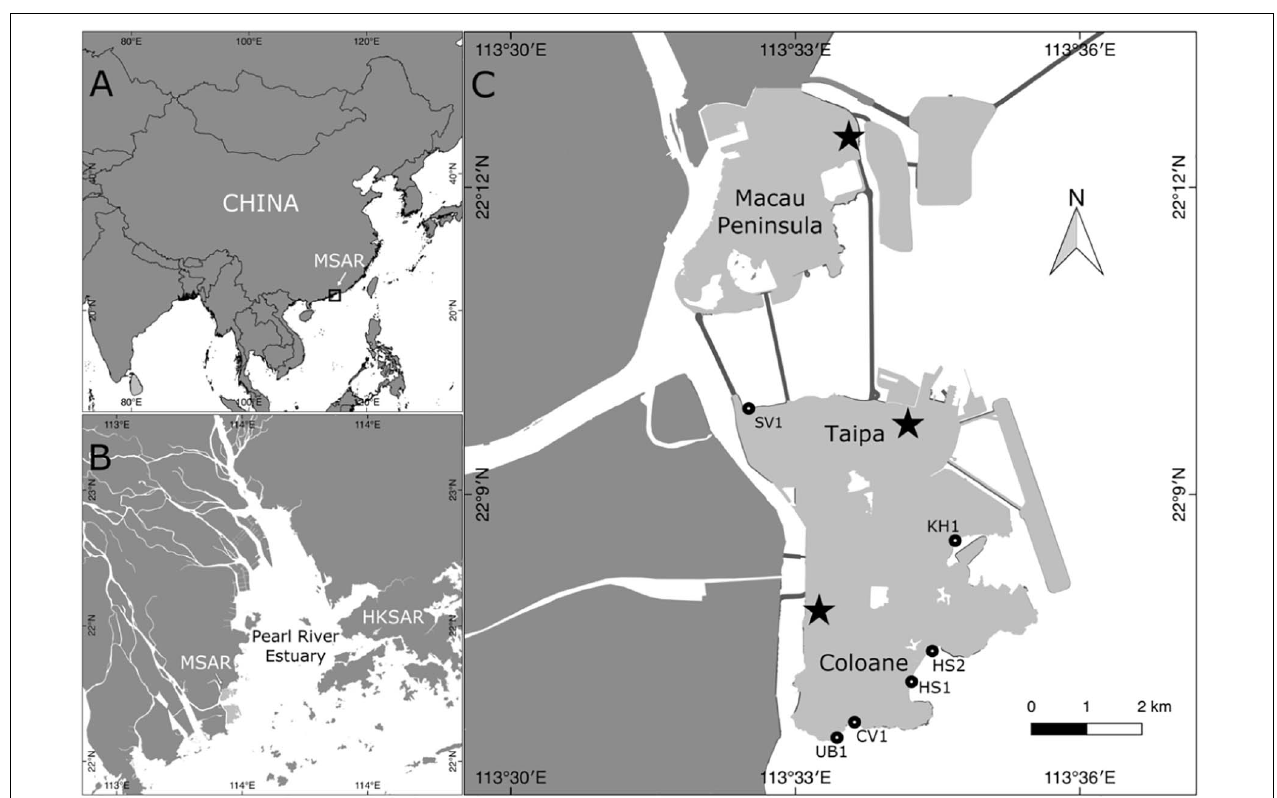
FIGURE 1 | Location of Macao within China (A) and the Pearl River Estuary (B) and position of the six sampling sites around Macao (C) . Sampling was undertaken at an unidentified beach west of Cheoc Van beach (UB1), Cheoc Van beach (CV1), Hac Sa beach west (HS1) and East (HS2), Ka-Ho (KH1) and close to Sai Van bridge at Taipa side (SV1). At each site, three sediment replicates were collected along the beach strandline. The star symbol represents the location of the three main waste water treatment plants of Macao. MSAR, Macao Special Administrative Region; HKSAR, Hong Kong Special Administrative